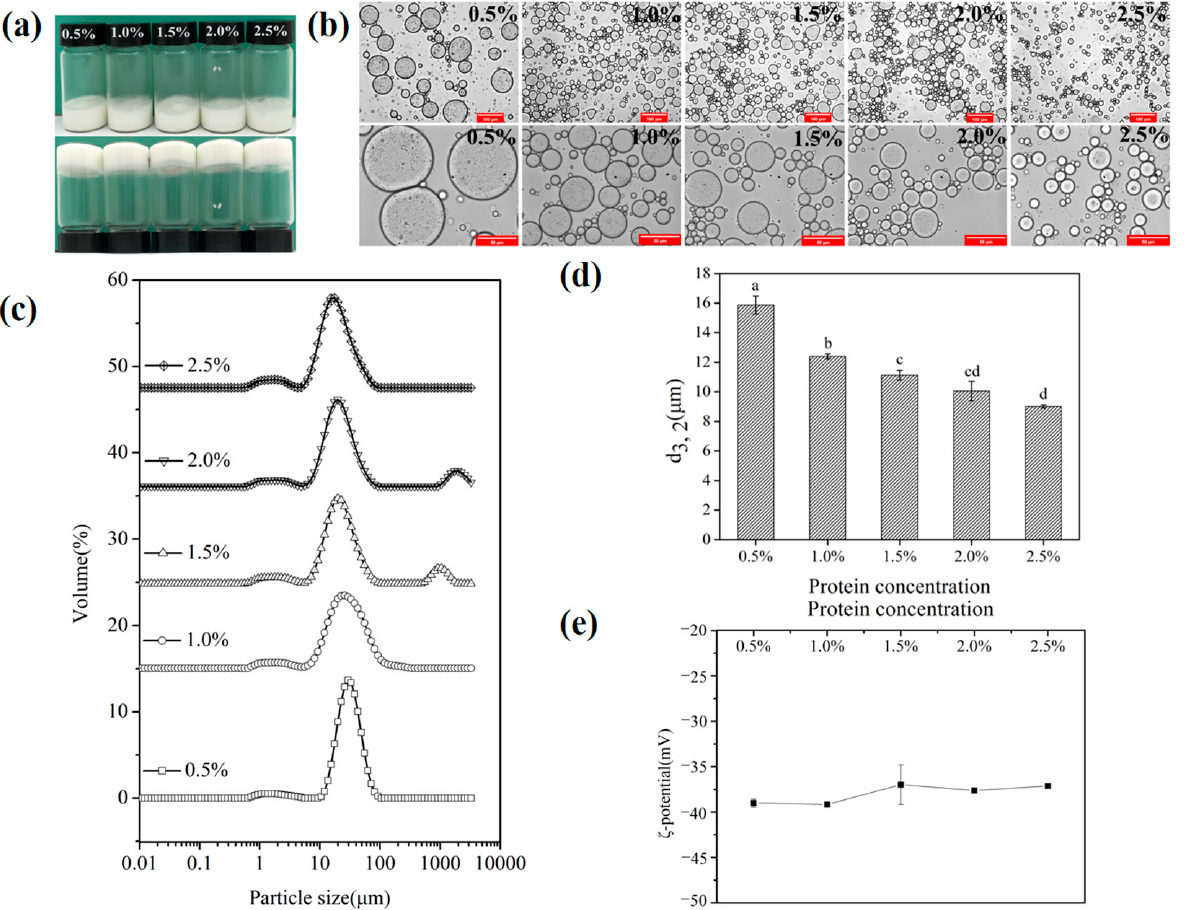
Figure 4. Visual appearance ( a ) and optical micrographs ( b ) (dilute the sample 10 times) (Scale bars, 100 μ m and 50 μ m, respectively) of W 1 /O/W 2 emulgels (W 1 /O primary emulsion, 10%) by different concentrations of SSPs (W 2 , 0.5 wt%, 1.0 wt%, 1.5 wt%, 2.0 wt%, and 2.5 wt%). Particle size distributions ( c ), droplet size (d 3,2 ) ( d ), and ζ -potential ( e ) of double emulsions with different SSP concentrations. Different letters in sub-figure ( d ) means significance difference ( p <